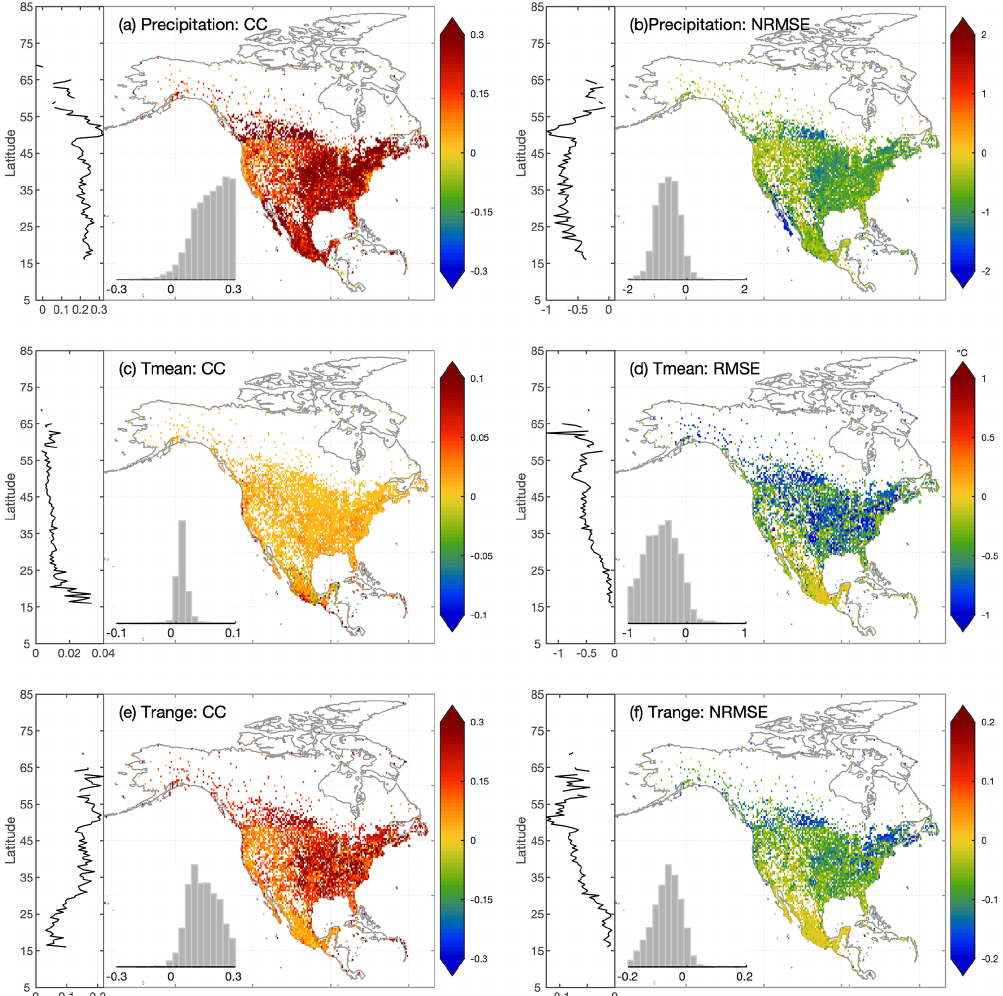
Figure 6. The differences of (a) CC and (b) NRMSE (normalized RMSE) between OI-merged precipitation estimates and BMA-merged reanalysis precipitation estimates. The latitudinal distributions of metrics are attached on the left side, showing the median value for 0.5 ◦ latitude bands. Panels (c–d) are the same as (a–b) but for mean temperature, and RMSE is not normalized. Panels (e–f) are the same as (a–b) but for daily temperature